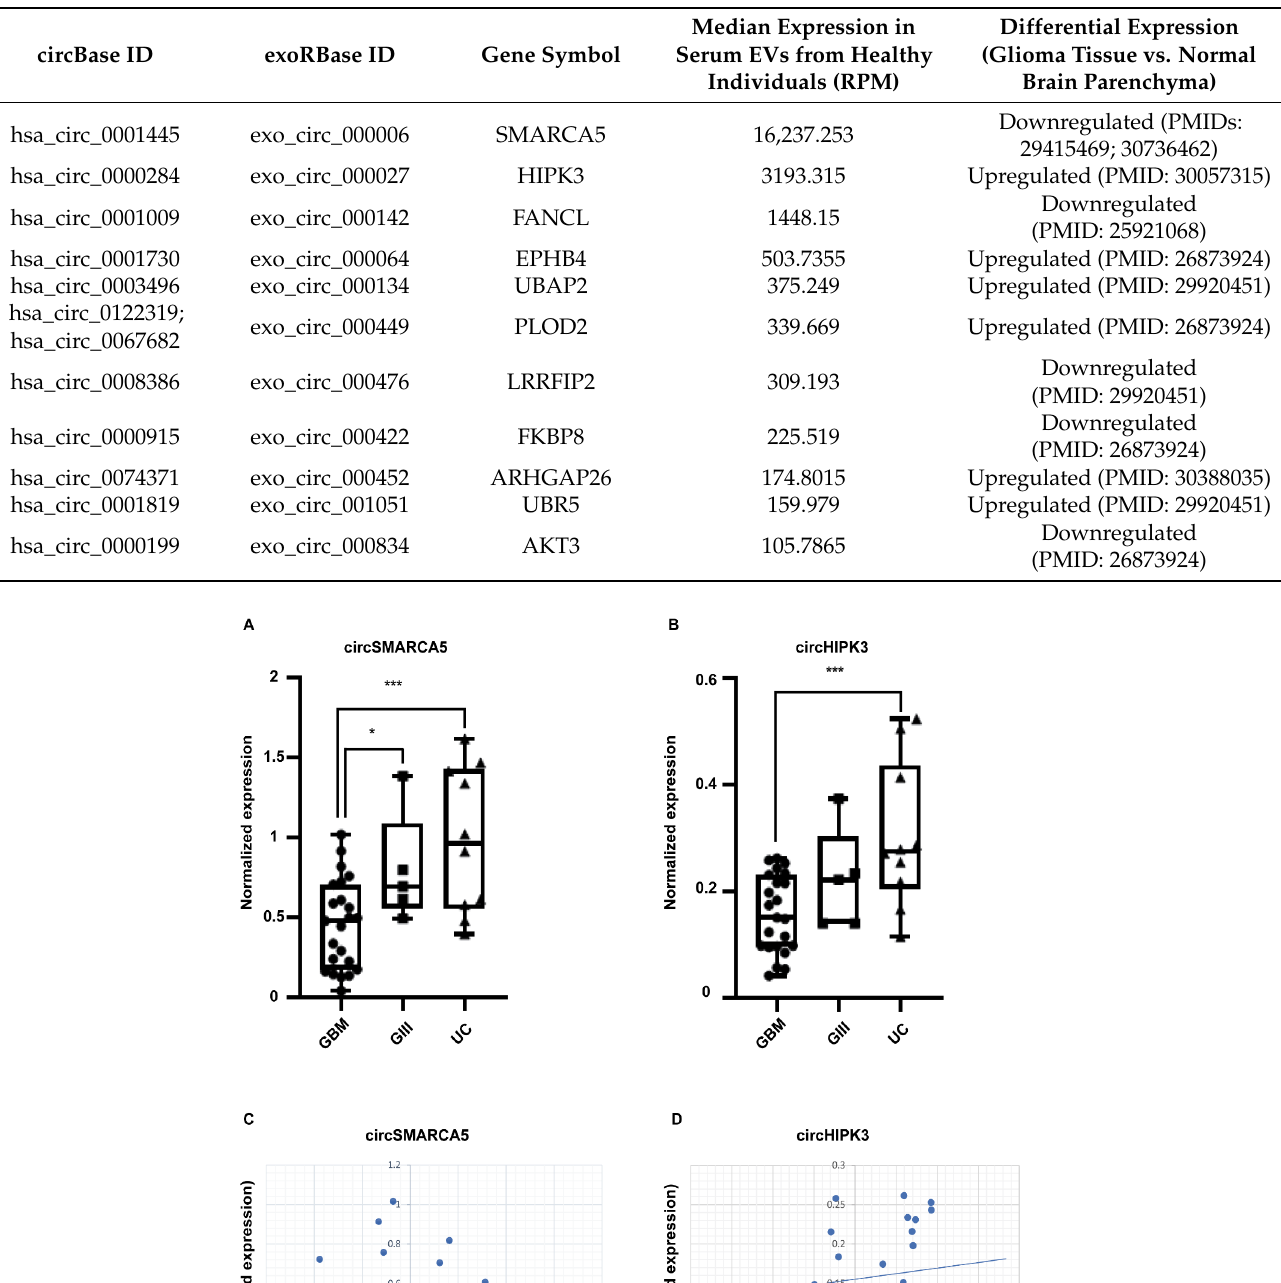
Table 1. Candidate DE circRNAs in gliomas and their expression in sEVs from healthy individuals according to exoRBase (http://www.exorbase.org/exoRBase/toIndex, access on April 2020). Median expression data are reported as reads per million (RPM).